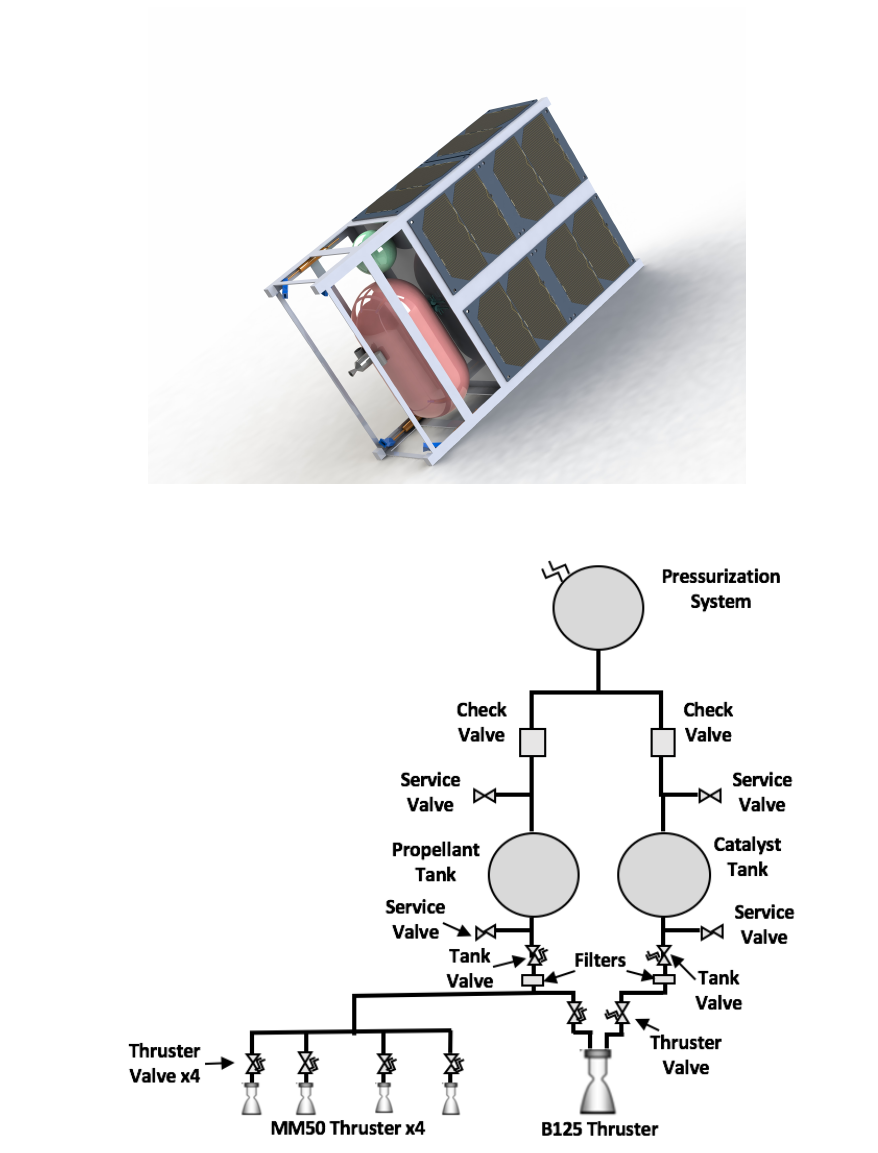
Figure 6. Summary of the B125 Propulsion System in development: ( top ) a solid model rendering of an envisioned 6U cubesat architecture; and ( bottom ) a system schematic diagram. Note that the tank configuration depicted above is not the tank configuration for the laboratory testing described in this study. Table 3. Summary of Key Propulsion System